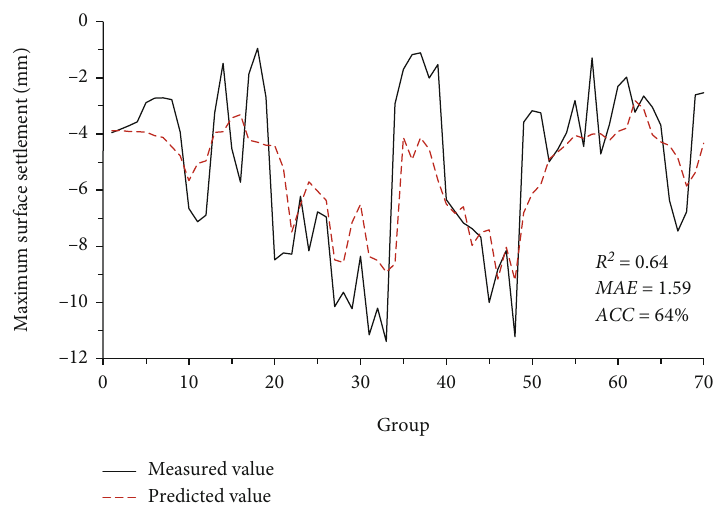
Figure 3: Prediction of original model with all